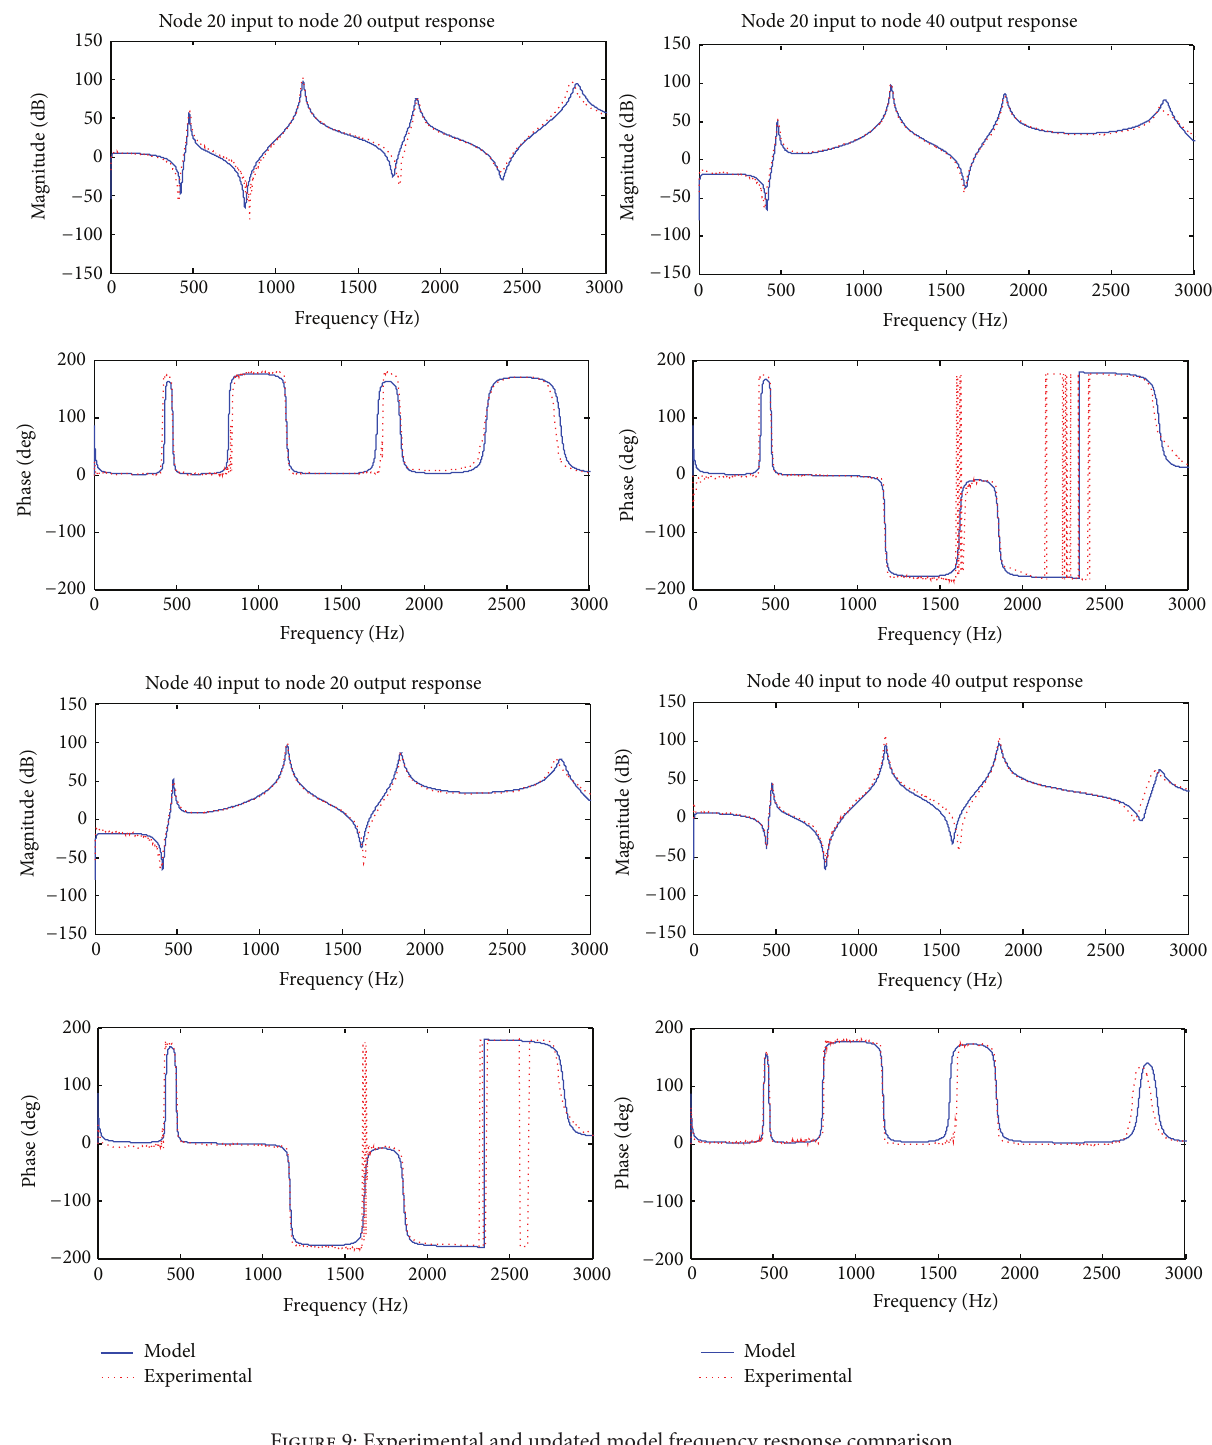
Figure 9: Experimental and updated model frequency response